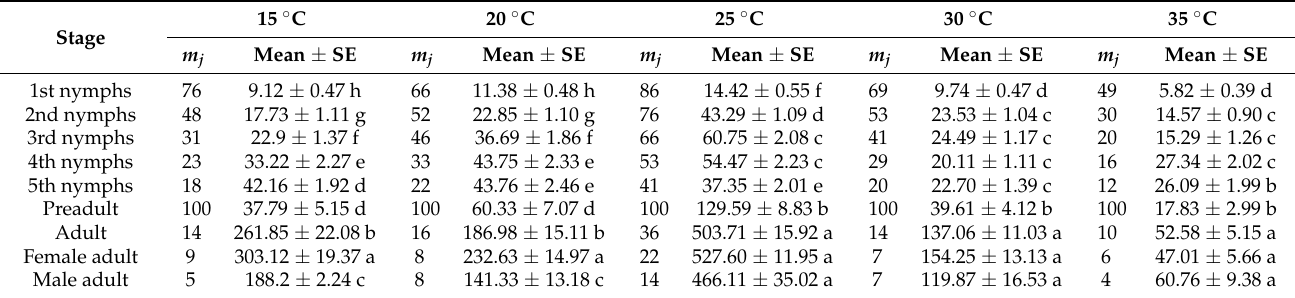
Table 4. Predation rate at different stage including individuals that died at j ( U j ) of O. minutus